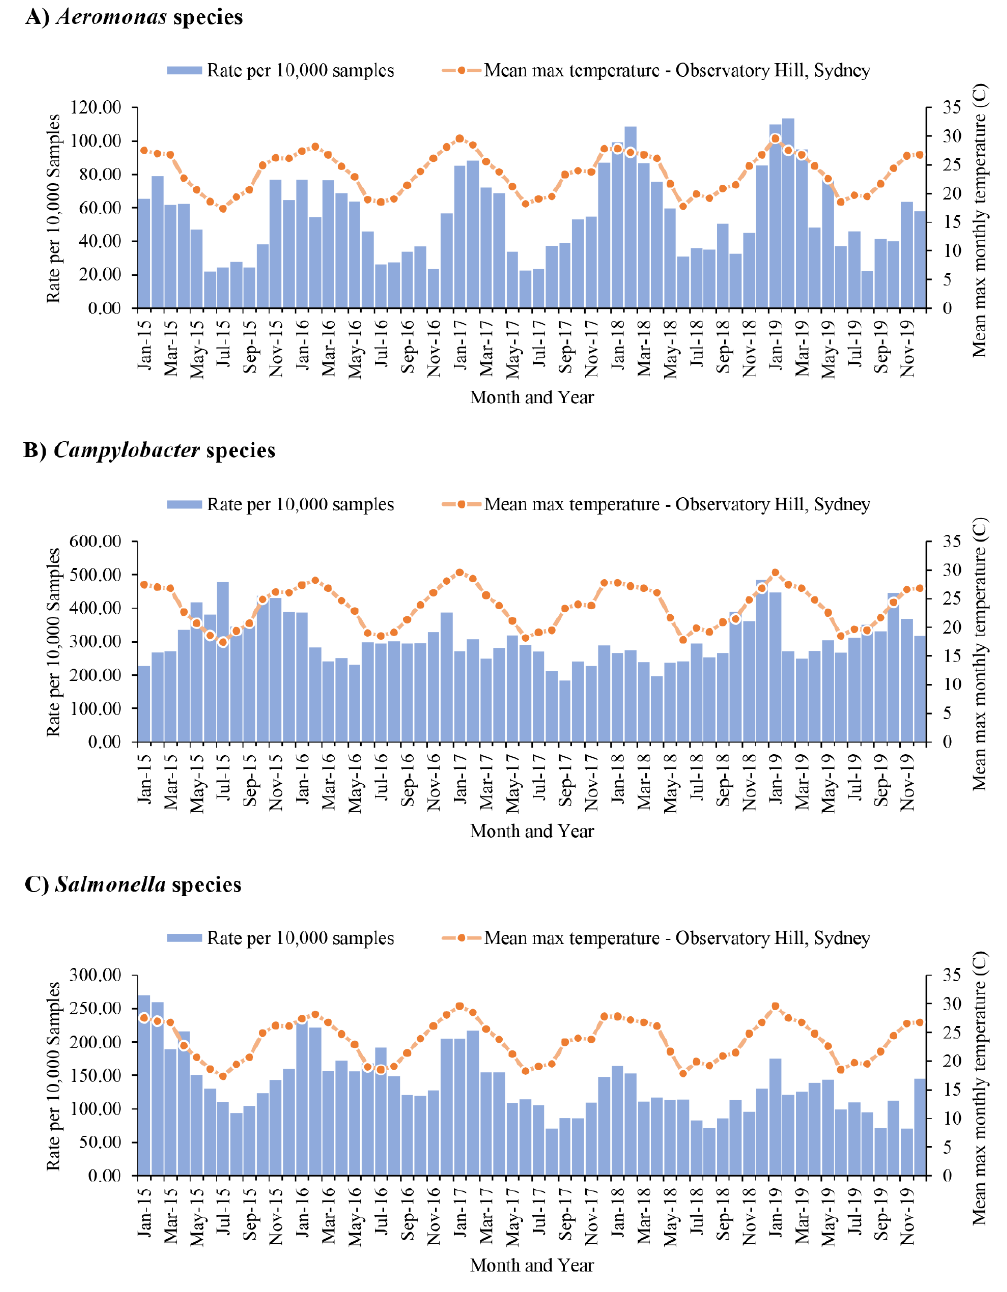
Figure 3. Isolation of Aeromonas species, Campylobacter species and Salmonella species in individual month during 2015–2019. The bacterial pathogens were isolated from faecal samples of patients with gastroenteritis. The isolation rates were the positive isolations per 10,000 samples. The mean maximum temperature was from Observatory Hill, Sydney. ( A ) Aeromonas species, ( B ) Campylobacter species and ( C ) Salmonella species. There was a strong positive correlation between Aeromonas species isolation rate and the local monthly mean maximum temperatures ( p < 0.001, the Spearman’s rank correlation coefficient = 0.807). Aeromonas species were more often isolated in January, February, March and April each year. The isolation rates started to decrease in May and maintained at low isolation rates from June to November. In December, Aeromonas isolation started to increase again (Figure 3A). The isolation rate of Campylobacter species isolation was not significantly associated with the change of temperature, p = 0.835 and the Spearman’s rank correlation coefficient was − 0.027 (Figure 3B). The isolation of Salmonella species was also positively associated with temperature, with p < 0.001 and the Spearman’s rank correlation coefficient 0.539 (Figure